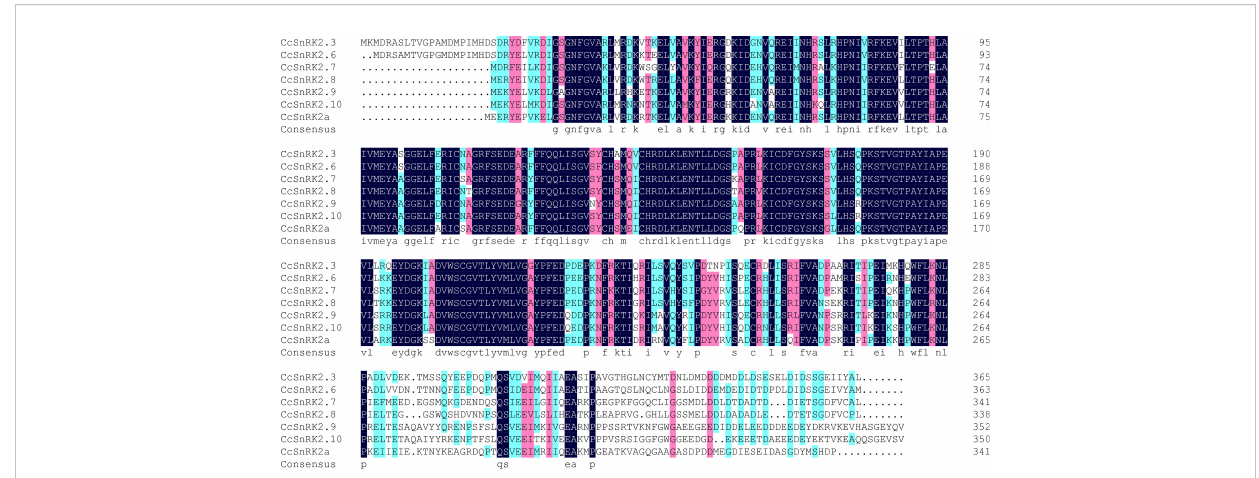
FIGURE 4 Amino acid sequence comparison of CcSnRK2s. Blueblack background: 100% similarity; blue: > 80% similarity; pink: > 50% similarity.